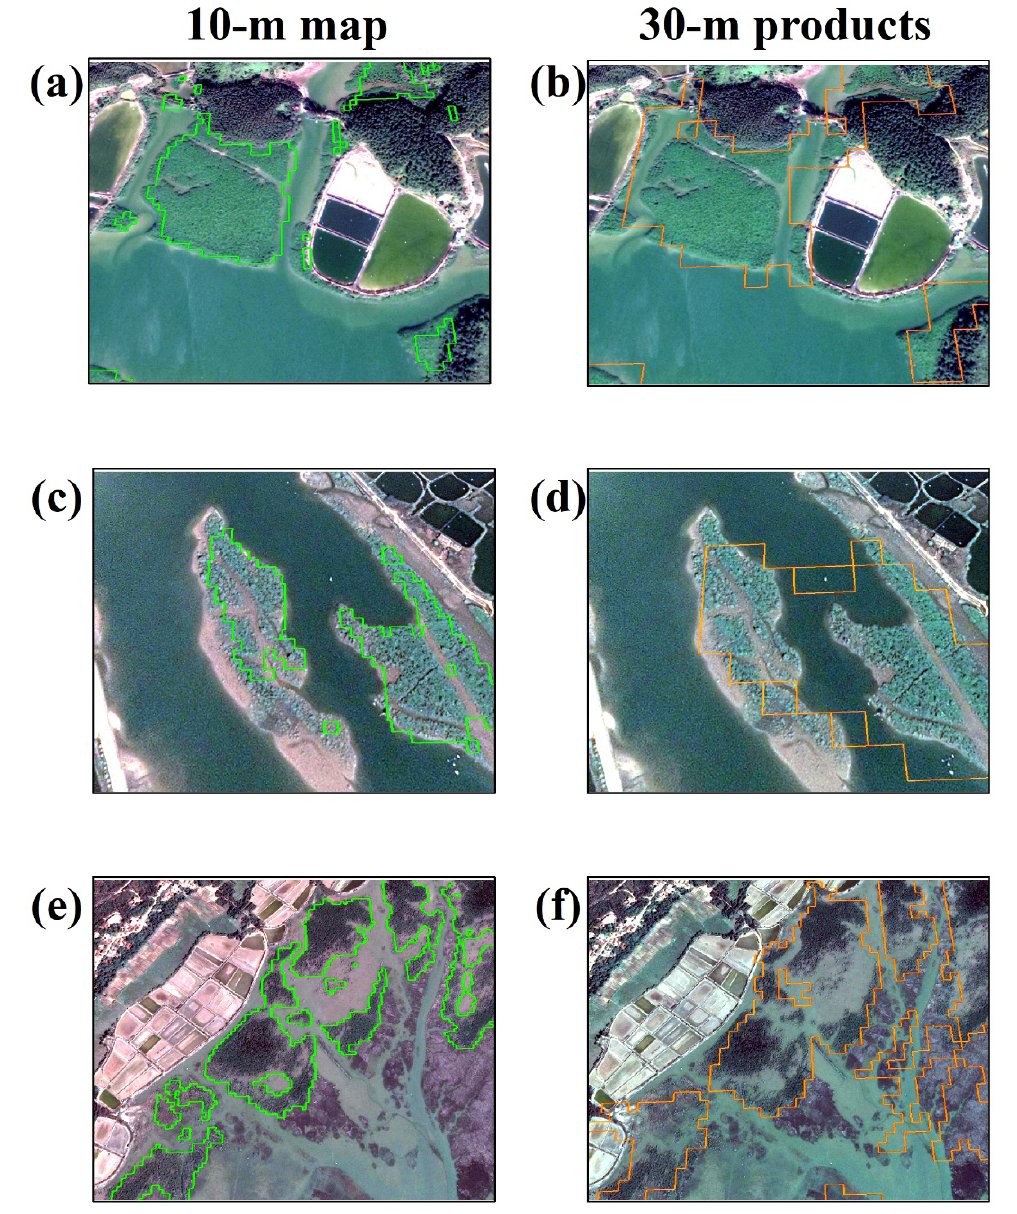
Figure 10. A comparison of mangrove extraction results derived from our 10-m map and 30-m products in regions where mangrove area di ff erences are smaller than 100 ha. The green and orange color represents the boundary of the 10-m and 30-m mangrove map. ( a , b ) are the comparison results between our 10-m map and MFM_2015; ( c , d ) are the comparison results between our 10-m map and MFP_2015; ( e , f ) are the comparison results between our 10-m map and GMW_2016.